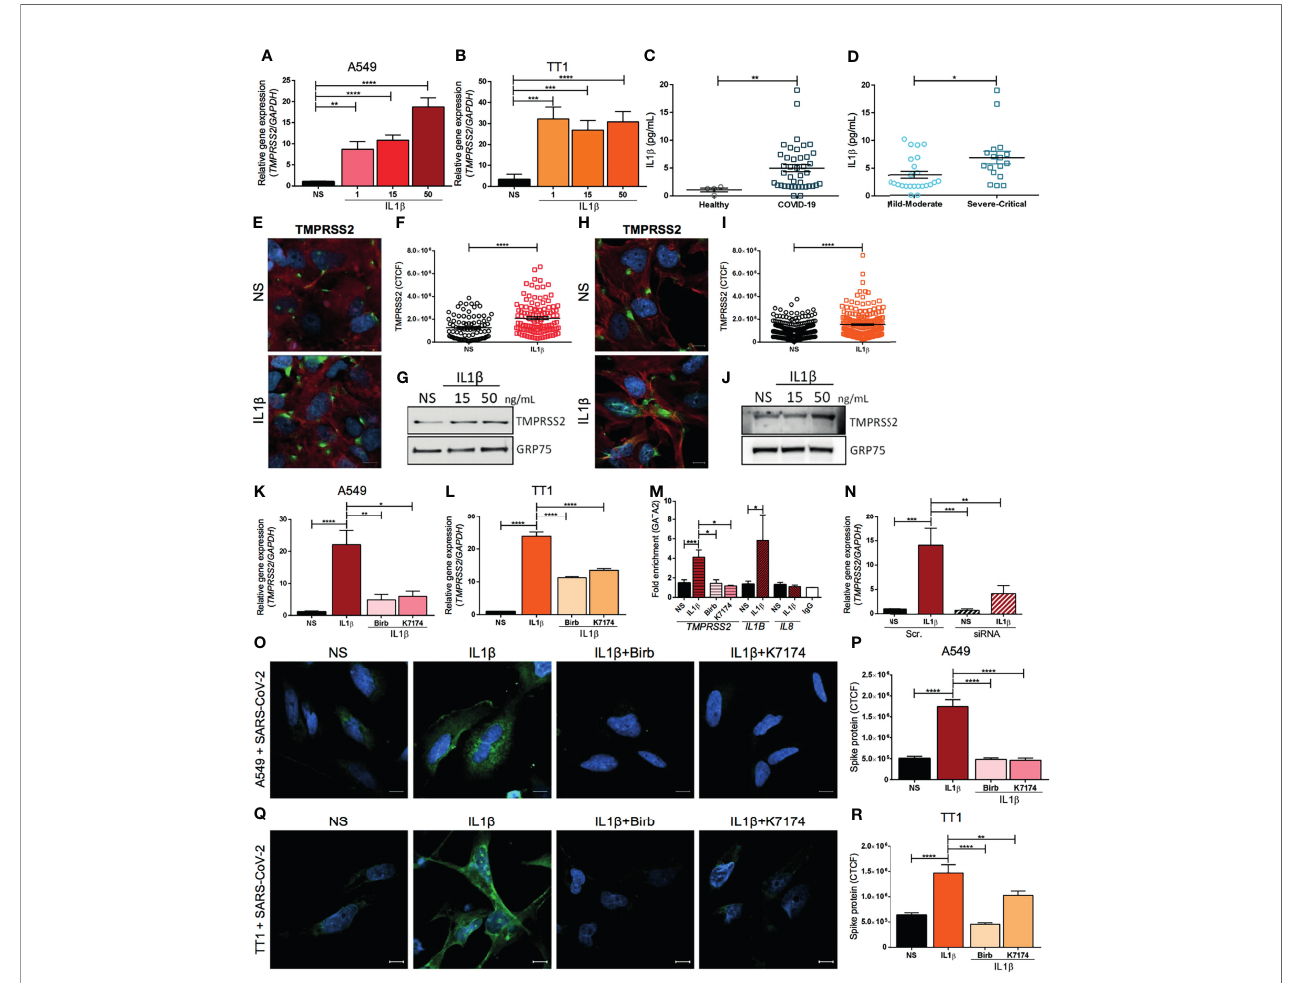
FIGURE 1 | TMPRSS2 expression is up-regulated by in fl ammatory cytokines enhancing SARS-CoV-2 entry in human lung cells. RT-qPCR analysis of the relative gene expression of TMPRSS2 in (A) A549 and (B) TT1 cells either stimulated or not (NS) for 4 hours with IL1 b (1, 15 or 50 ng/mL); n=5 independent experiments. IL1 b plasma concentration (pg/mL) (C) in healthy, age-matched controls and COVID-19 patients, and (D) in COVID-19 patients grouped by disease severity (mild- moderate versus severe-critical); n=44 patients. (E) Representative immuno fl uorescence for TMPRSS2 and (F) quanti fi cation of fl uorescence intensity of TMPRSS2 (green) in A549 cell line either stimulated or not (NS) for 24 hrs with IL1 b (50 ng/mL). Nuclei were counterstained with Hoechst 33342 (blue) and actin was stained with Phalloidin TexasRed (Red). CTCF: corrected total cell fl uorescence. Scale bar: 10 m m; n=3 independent experiments. (G) Western blot analysis of TMPRSS2 in total protein lysates from A549 cells stimulated or not (NS) for 24 hours with IL1 b (15 or 50 ng/mL); GRP75 was used as a loading control (representative of 3 independent experiments). (H) Representative immuno fl uorescence for TMPRSS2 and (I) quanti fi cation of fl uorescence intensity of TMPRSS2 (green) in TT1 cell line either stimulated or not (NS) for 24 hrs with IL1 b (50 ng/mL). Nuclei were counterstained with Hoechst 33342 (blue) and actin was stained with Phalloidin TexasRed (Red). CTCF, corrected total cell fl uorescence. Scale bar: 10 m m; n=3 independent experiments. (J) Western blot analysis of TMPRSS2 in total protein lysates from TT1 cells stimulated or not (NS) for 24 hours with IL1 b (15 or 50 ng/mL); GRP75 was used as a loading control (representative of 3 independent experiments). RT- qPCR analysis of the relative gene expression of TMPRSS2 in (K) A549 or (L) TT1 cells stimulated for 4 hours with IL1 b (50 ng/mL) and either treated or untreated with Birb796 (p38 MAPK inhibitor, 100 nM) or K7174 (GATA2 inhibitor, 10 µM). NS, Not Stimulated; n=5 independent experiments. (M) ChIP-RTqPCR analysis of the fold enrichment of GATA2 binding to the TMPRSS2 enhancer promotor region, in A549 cells either treated or untreated with Birb796 (p38 MAPK inhibitor, 100 nM) or K7174 (GATA2 inhibitor, 10 µM) and stimulated or not (NS) for 4 hours with IL1 b (50 ng/mL). Data were adjusted by input for each sample and normalized with IgG (Mock). The fold enrichment of GATA2 binding to the IL1B and to the IL8 promotors was respectively used as positive and negative control. IgG was used as antibody speci fi city control. N=3 independent experiments. (N) RT-qPCR analysis of the relative gene expression of TMPRSS2 in A549 cells upon GATA2 silencing with or without stimulation with IL1 b (50 ng/mL) for 4 hours. Scramble siRNA (Scr.) was used as a negative control; n=4 independent experiments. (O) Representative confocal images and (P) quanti fi cation of fl uorescence intensity of SARS-CoV-2 Spike protein (green) in A549 cells upon infection with heat- inactivated SARS-CoV-2 virus. Cells were stimulated or not (NS) for 8 hours with IL1 b (50 ng/mL) and either treated or not with Birb796 (p38 MAPK inhibitor, 100 nM) or K7174 (GATA2 inhibitor, 10 µM). Nuclei were counterstained in blue (Hoechst 33342). Scale bar: 10 m m; n=3 independent experiments. (Q) Representative confocal images and (R) quanti fi cation of fl uorescence intensity of SARS-CoV-2 Spike protein (green) in TT1 cells upon infection with heat-inactivated SARS-CoV-2 virus. Cells were stimulated or not (NS) for 8 hours with IL1 b (50 ng/mL) and either treated or not with Birb796 (p38 MAPK inhibitor, 100 nM) or K7174 (GATA2 inhibitor, 10 µM). Nuclei were counterstained in blue (Hoechst 33342). Scale bar: 10 m m; n=3 independent experiments. Data are presented as means ± SEM. nonparametric Mann – Whitney U test (C, D, F, I) or Kruskal-Wallis test for multiple comparisons with Dunn ’ s post hoc (A, B, K, L, M, N, P, R) *P < 0.05, **P < 0.01, ***P < 0.001, ****P <